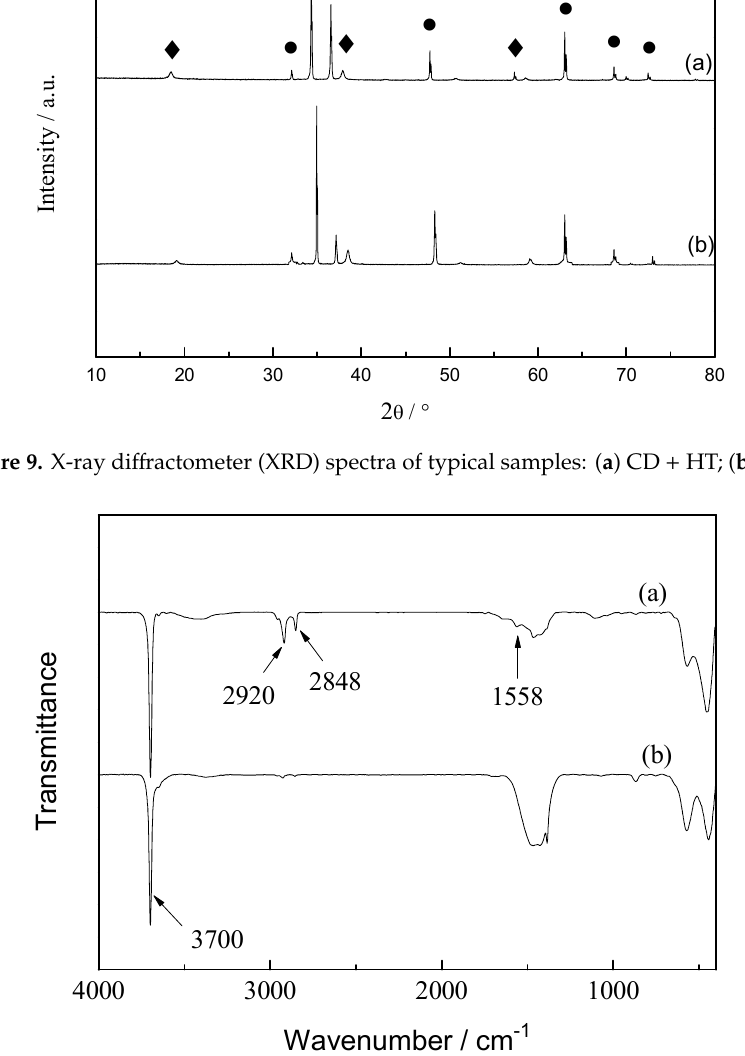
Figure 10. Fourier transform infrared spectrometer (FT-IR) spectra of typical sample surfaces: ( a ) CD + HT; ( b ) CD.